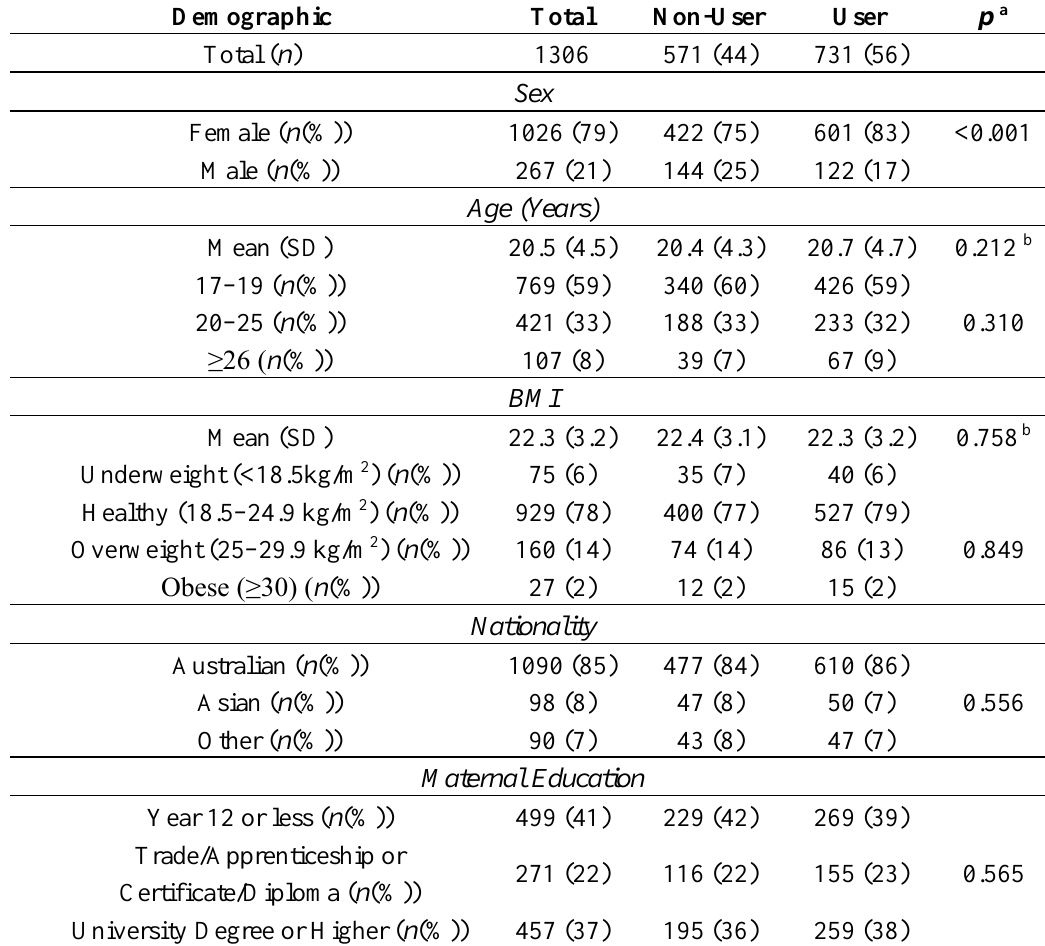
Table 1. Demographic Characteristics of participants and their association with supplement